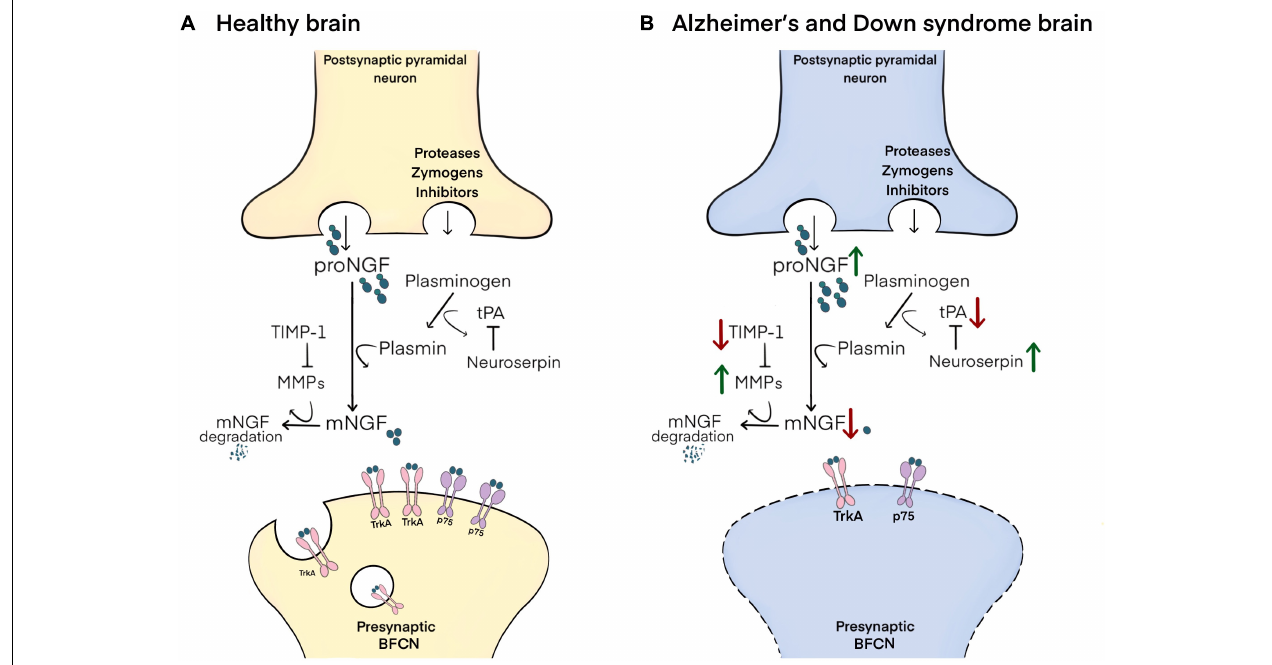
FIGURE 1 | Schematic representation of the NGF metabolic pathway and its altered state in Alzheimer’s and Down syndrome pathology. (A) In the healthy brain, proNGF is co-released in the extracellular space with zymogens and convertases involved in its maturation and degradation. proNGF is cleaved to yield mNGF by plasmin, itself derived from the cleavage of plasminogen by tPA, a process regulated by neuroserpin. mNGF then dimerizes and binds to p75/TrkA receptor complexes on presynaptic terminals of BFCNs, followed by the retrograde transport of mNGF to their cell bodies in the basal forebrain. Receptor-unbound mNGF is rapidly degraded by MMP-9 and MMP-3, which are produced from their pro-proteins under the control of TIMP-1. (B) In Alzheimer’s disease and in Down syndrome brains, increased neuroserpin and decreased tPA lead to reductions in the maturation of proNGF to mNGF by limiting plasmin concentrations. Further, decreased TIMP-1 and increased MMP-3/MMP-9 result in the excessive degradation of unbound mNGF. These changes result in impaired trophic support to BFCNs, leading to their